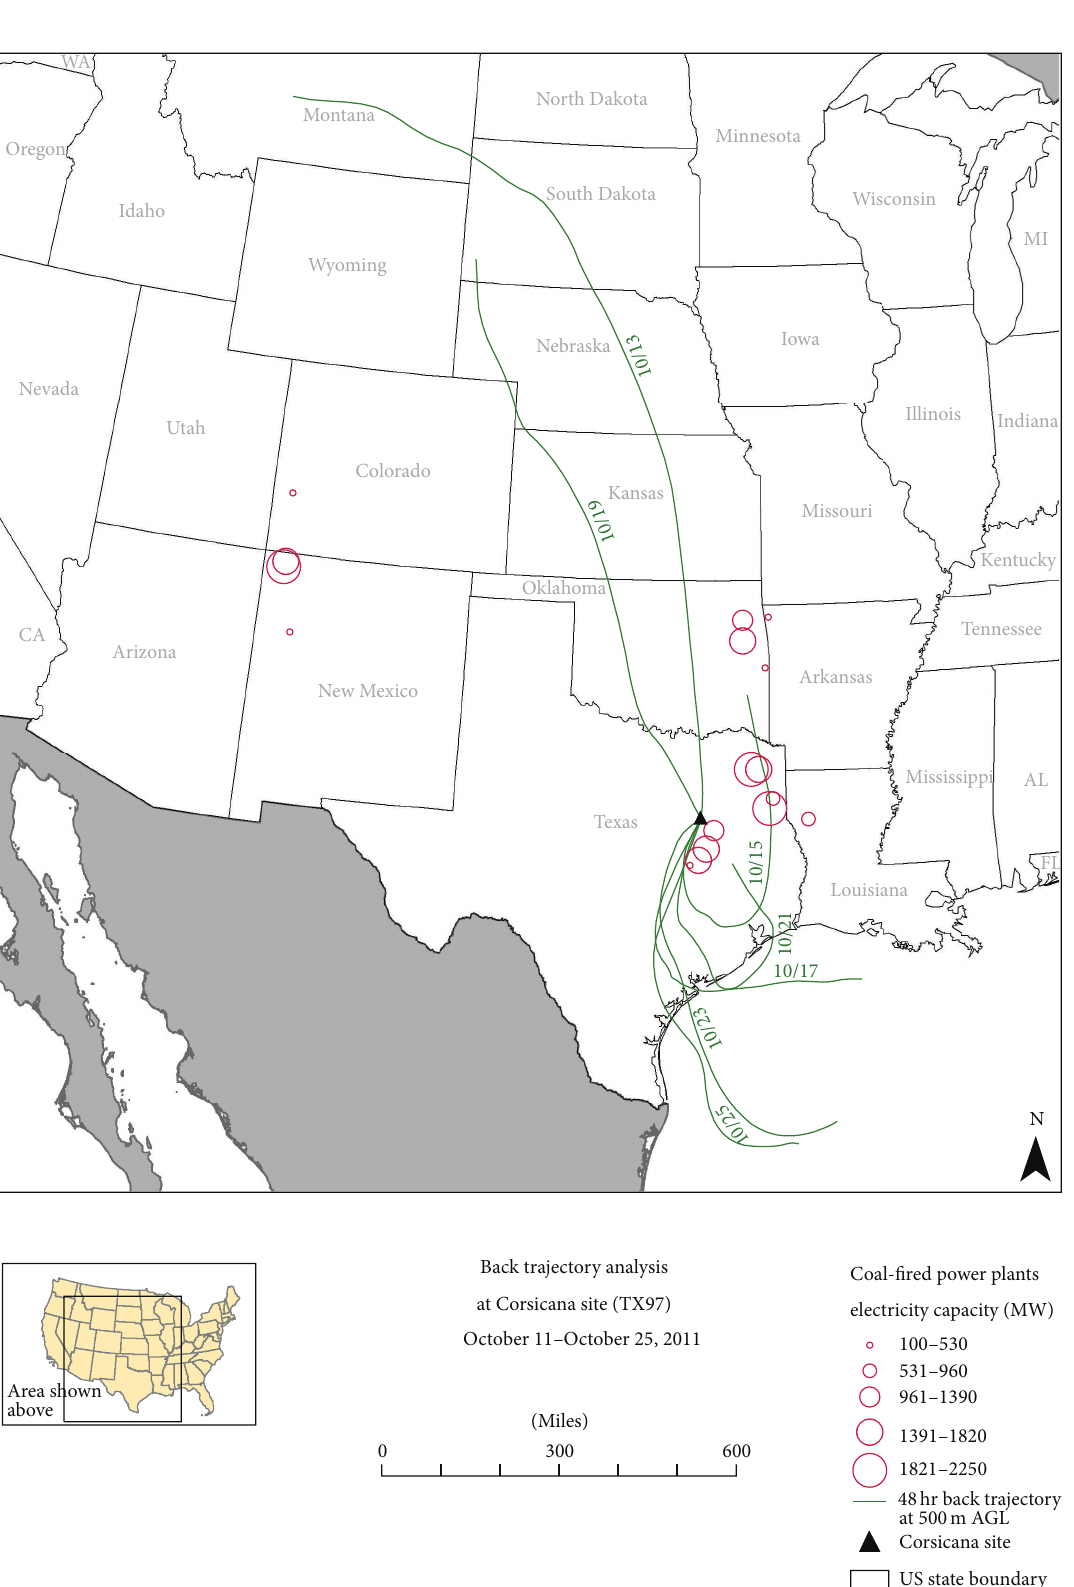
Figure 4: Back trajectory analysis for the Corsicana site (TX97) for October 11 to October 25, 2011. Seven contiguous 48-hour back trajectories ending at 1000 LST on October 25, 2011. End date of each 48-hour back trajectory plotted for each trajectory trace (e.g., 10/13 represents 48- hour back trajectory for 10/11–10/13). Coal-fired power plant locations are located at center of open